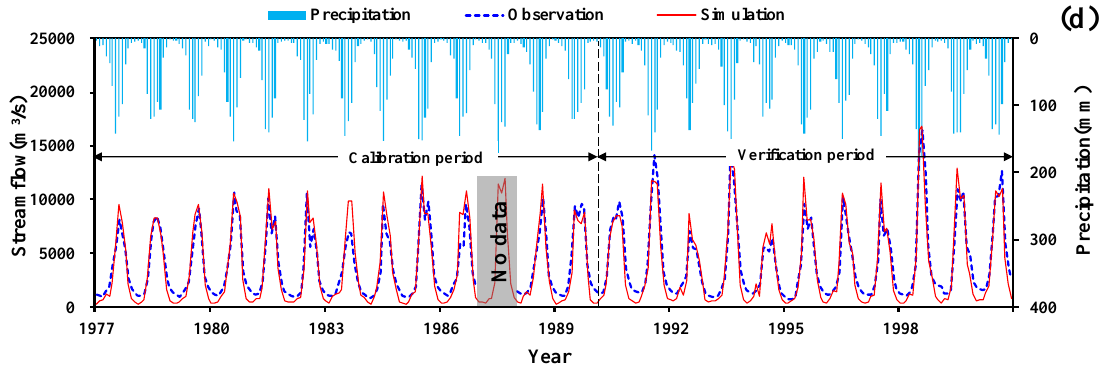
Figure 7. Simulated and observed monthly discharge during the calibration period and the verification period: ( a ) Zhimenda catchment; ( b ) Shigu catchment; ( c ) Panzhihua catchment; ( d ) Huatan catchment.